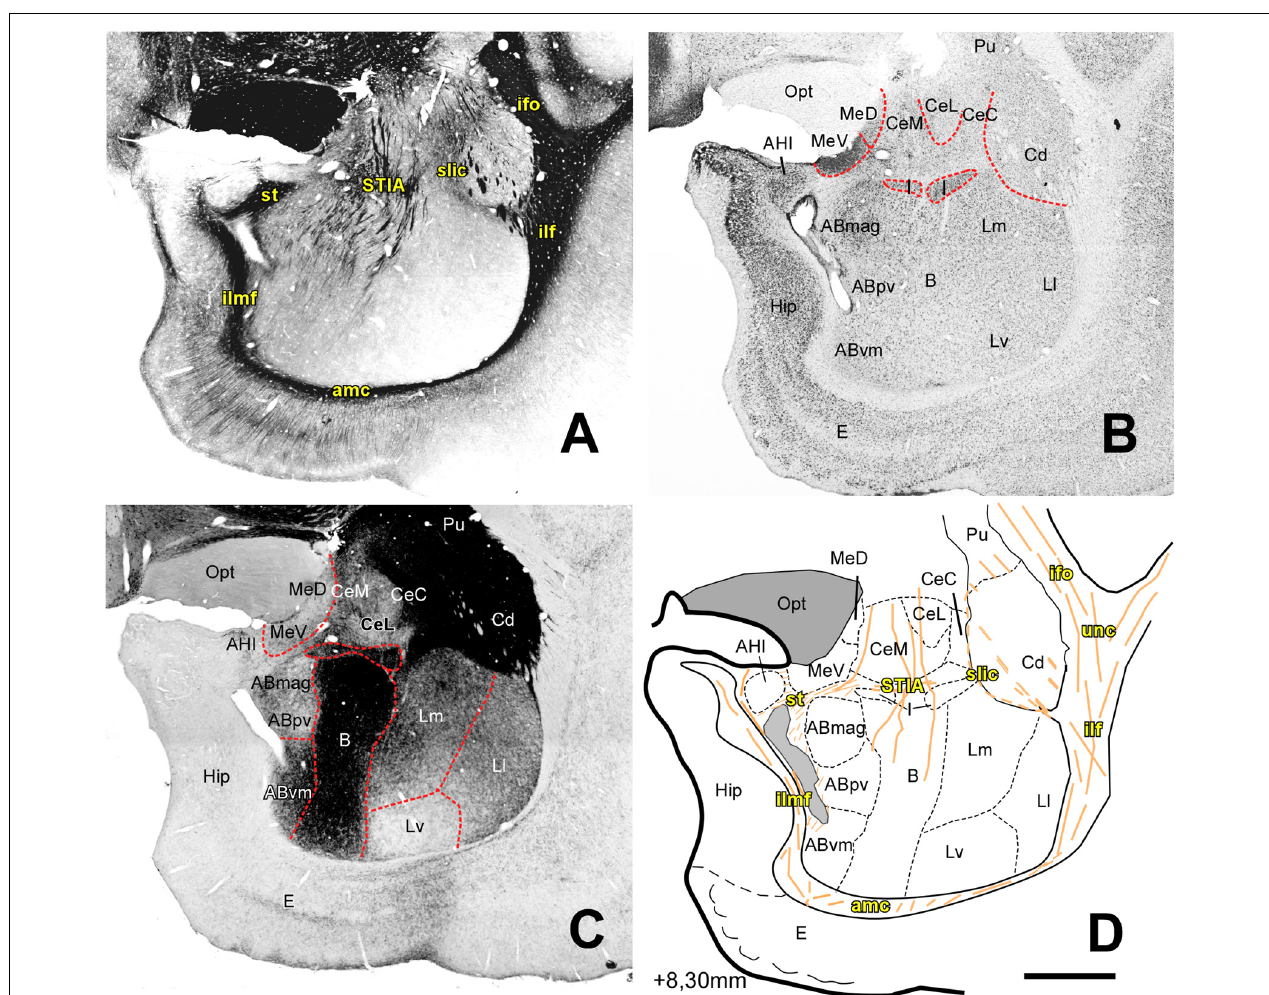
FIGURE 4 | Myelo- and cytoarchitecture, level 4 (Interaural 8.30 mm). Series of adjacent coronal sections stained for Gallyas (A) , Nissl (B) and AChE (C) and the corresponding drawing showing in black the territories of the AC and in orange the myelinic bundles schematically (D) . Unambiguous nuclear boundaries are drawn with a red dashed line. At this level, the Hip appears medial to the AC, the cytoarchitectonic profile of the B and AB nuclei becomes diffuse, and the Ld subdivision is not distinguishable in the L. The divisions of the Ce show differences in the AChE staining at this level, with the capsular subdivision being more intensely stained (C) . The location of the I coincides with an intense myelin stained region and with an appearance of the st and its intraamygdaloid component (STIA). Scale: 1